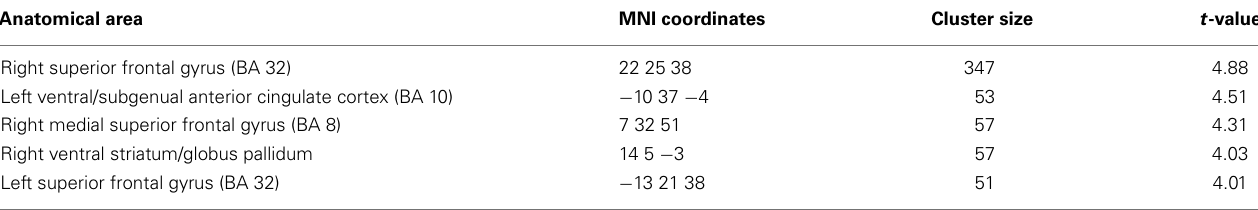
Table 5 | GMV increases (6-month − acute) in the MG compared to theABG and CG (LHD patients). Anatomical